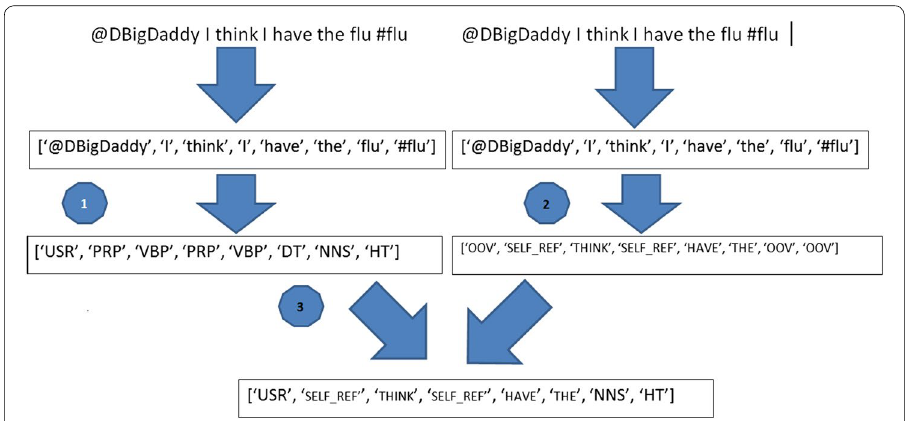
Fig. 6 Derivation of conceptual CNF representation from plain